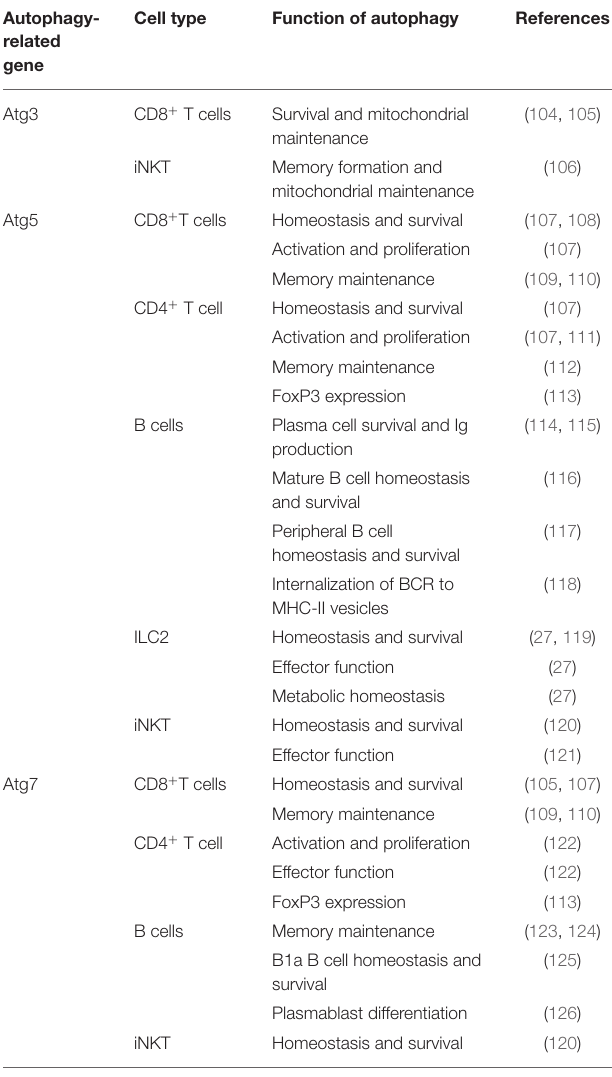
TABLE 2 | Summary table of autophagy in lymphocytes. Autophagy-